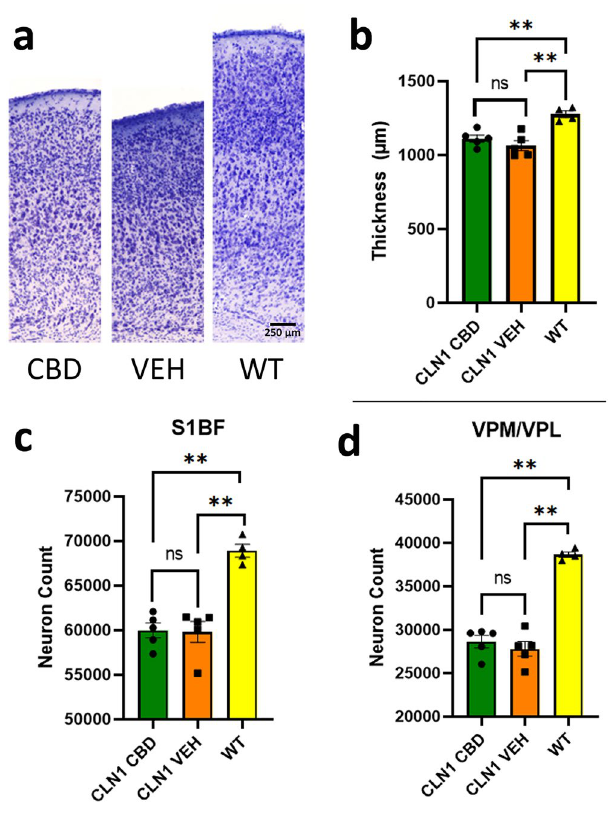
Figure 2. Chronic CBD does not affect neuron count or cortical thickness. ( a ) Nissl-stained depiction of cortical thickness. Treatment did not affect cortical thickness ( b ) or neuron count in the S1BF cortex ( c ) or VPM/VPL of the thalamus ( d ) in Cln1 −/− mice. Scale bar is 250